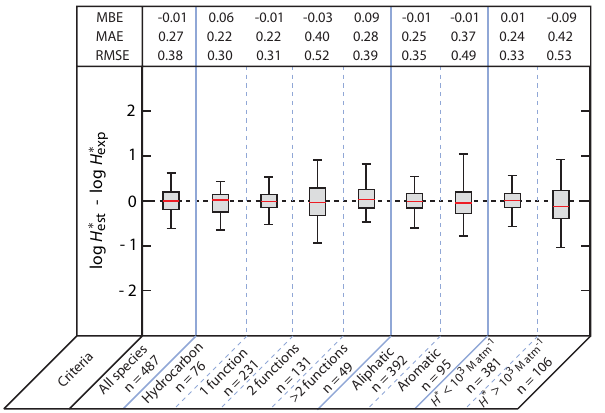
Fig. 4. Mean bias error (MBE), mean absolute error (MAE), root mean square error (RMSE) and box plot for the error distribution in the estimated log H ∗ value with the GROMHE method. The whiskers of the box plot show the 5th and 95th percentiles, the box shows the second and third quartile and the red line gives the me- dian value of the distribution.